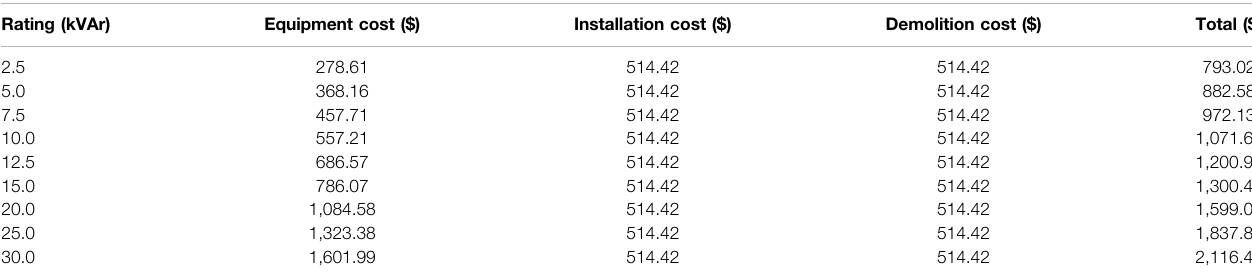
TABLE 1 | Size, price, installation and demolition cost of three-phase capacitor. Rating